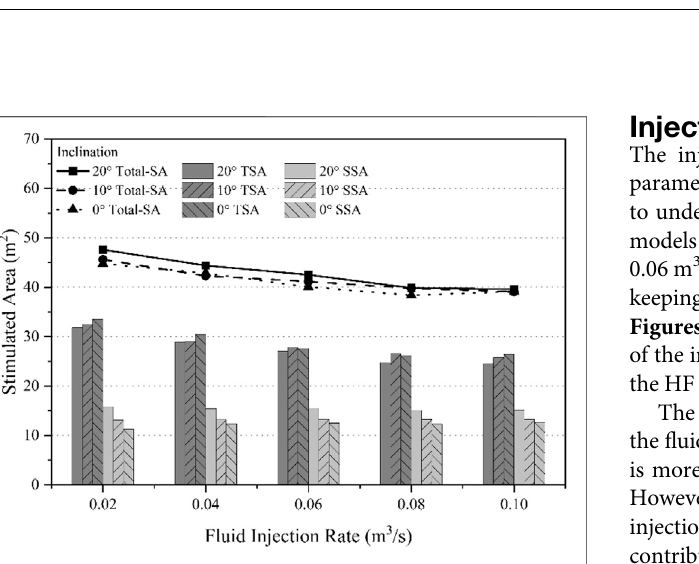
Frontiers in Earth Science |